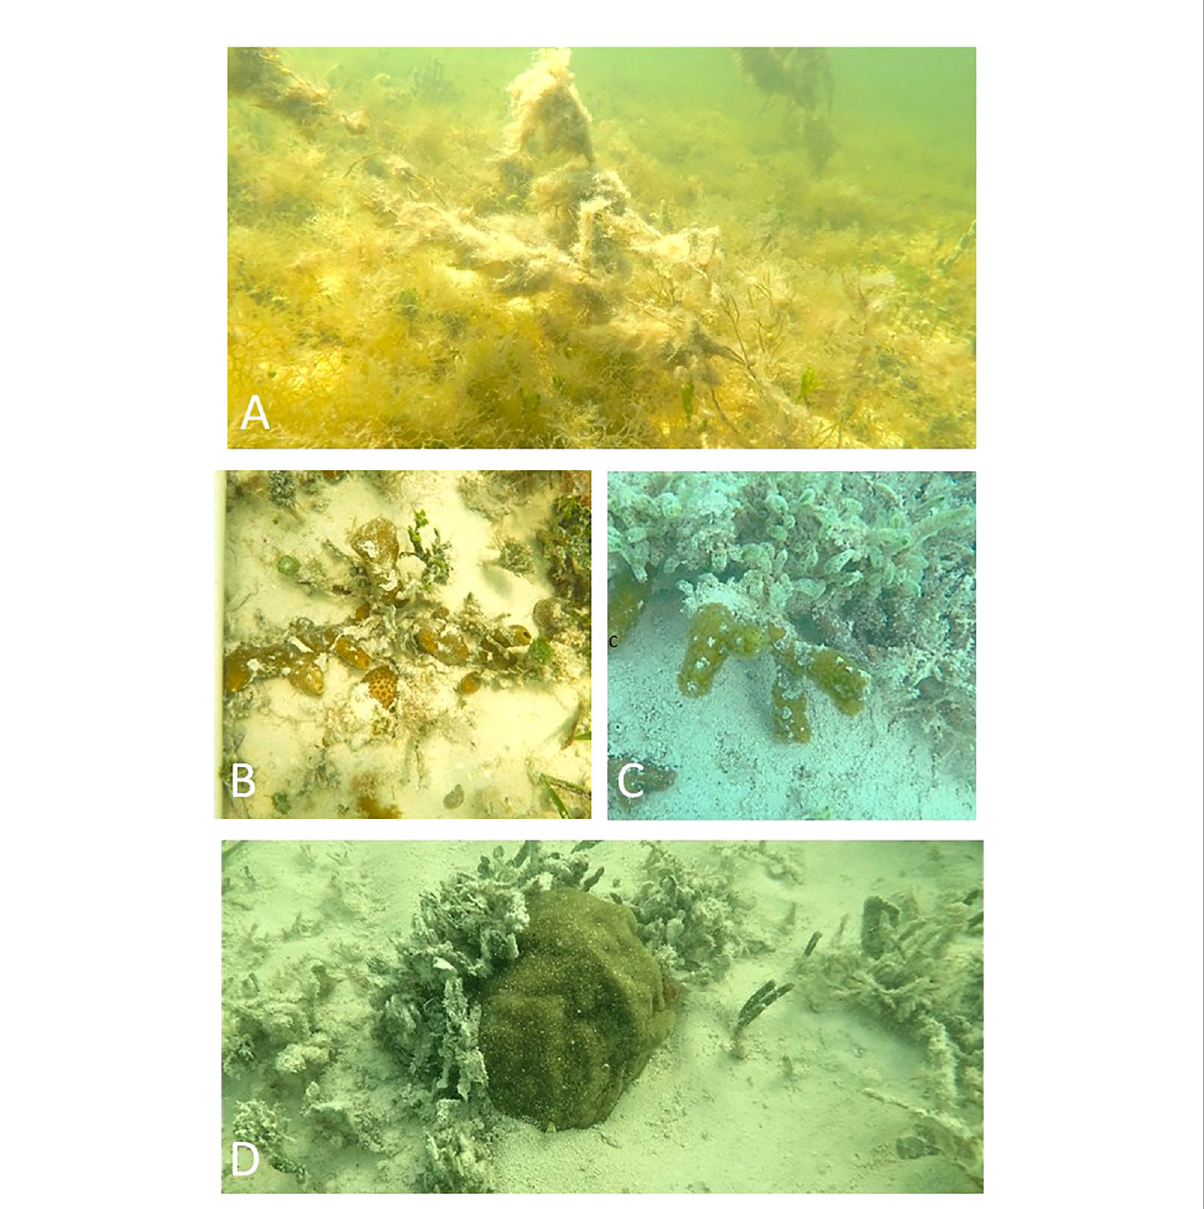
FIGURE 2 (A) Eutrophic conditions in nearshore benthic communities have created environmental conditions that are dif fi cult for stony corals to recruit, survive and reproduce. (B) S. radians colonies in a hard bottom community off Lignum Vitae Key (C) P. divaricata colony in hardbottom community off Bahia Honda, and (D) P. astreoides off Geiger